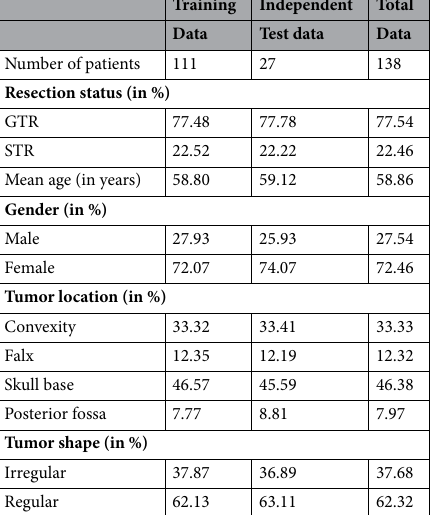
Table 1. Clinical and demographic characteristics.